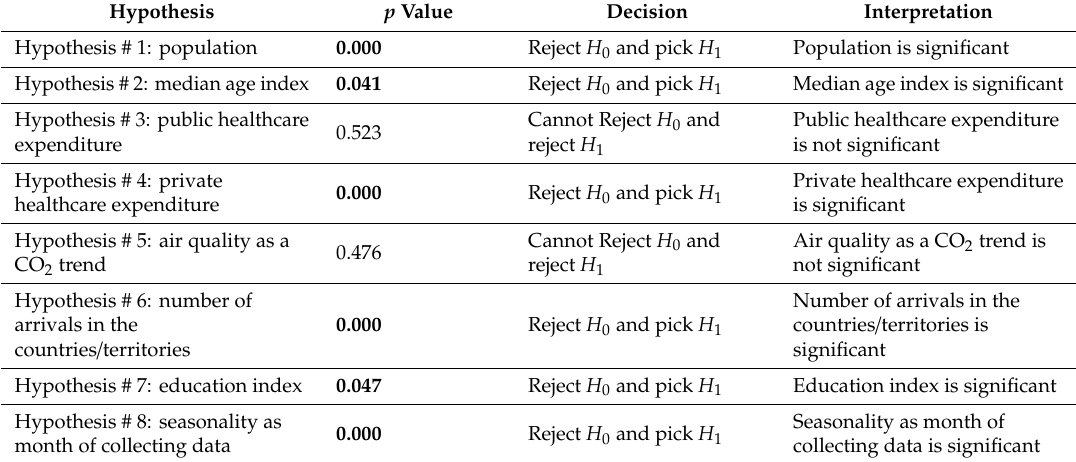
Table 2. Results of regression